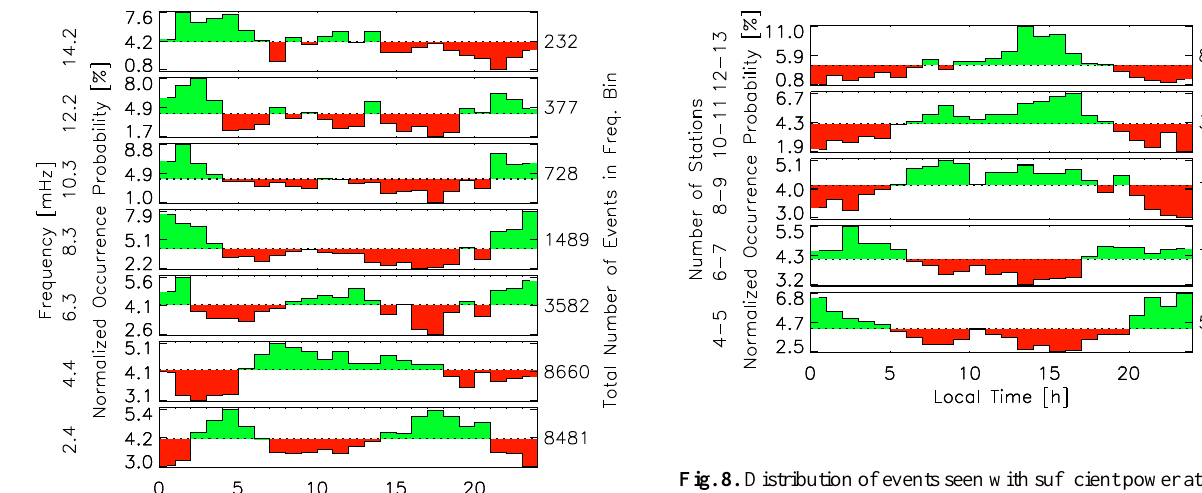
Fig. 8. Distribution of events seen with sufficient power at different numbers of stations against local time normalized by the distribu- tion of all events in local time. The percentage of occurrence of events is depicted as well as the total number of events (number at the right edge of the figure) seen at different numbers of stations to which this percentage corresponds. Red and green bars show the differences to the mean percentage of 100 / 24 indicated by the dotted lines. Local time binning: one